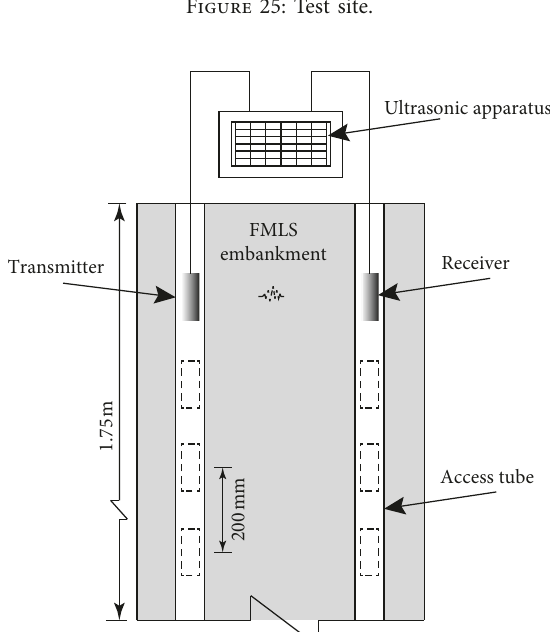
Figure 25: Test site.